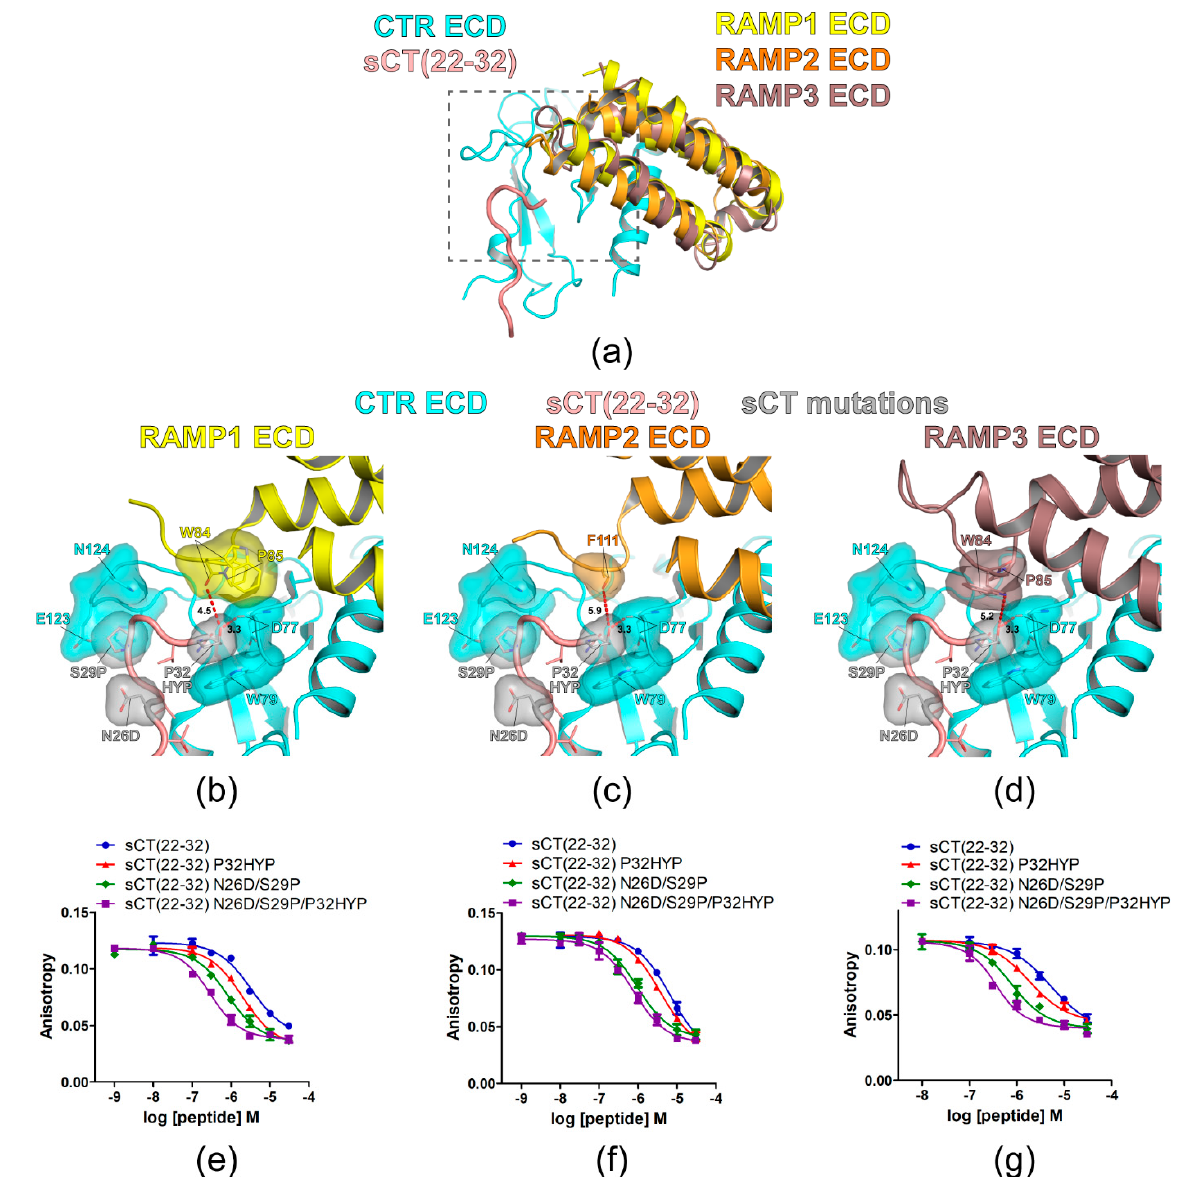
Figure 5. Hypothetical structures of AMY receptor ECDs and the peptide binding assay with sCT(22–32) N26D/S29P/P32HYP mutations. ( a ) Overview of the hypothetical structures of AMY receptor 1/2/3 ECDs. The crystal structure of CTR ECD (PDB 6PFO, Mol A) with sCT(22–32) and RAMP 1/2/3 ECDs structures from the CGRP (PDB 6E3Y) and AM1/2 receptors (PDB 6UUN and 6UVA) were used to build hypothetical AMY receptor 1/2/3 ECDs. The peptide binding pocket and proximal RAMP ECD residues were boxed with a gray dotted line. ( b – d ) Hypothetical structures of AMY receptor 1/2/3 ECDs with sCT(22–32) N26D/S29P/P32HYP mutations. CTR ECD D77, W79, H121, E123, and N124, sCT N26D, S29P, and P32HYP mutated residues, and RAMP ECD residues (W84 and P85 in RAMP1/3 ECD and F111 in RAMP2 ECD) were shown both with stick and surface representations. The distances between sCT HYP32 and the proximal RAMP ECD residue and between sCT HYP32 and the CTR ECD D77 main chain were shown as a dotted red line. For ( c ), the side chain of F111 of RAMP2 ECD was unavailable in the original cryo-EM structure (PDB 6UUN) and only the first carbon of the side chain was shown as stick and surface representations. ( e – g ) FP competition peptide binding assay with sCT(22–32) N26D/S29P/P32HYP mutations. FITC-AC413(6–25) with Y25 mutation was used as a peptide probe. Representative peptide-binding curves were shown from three independent